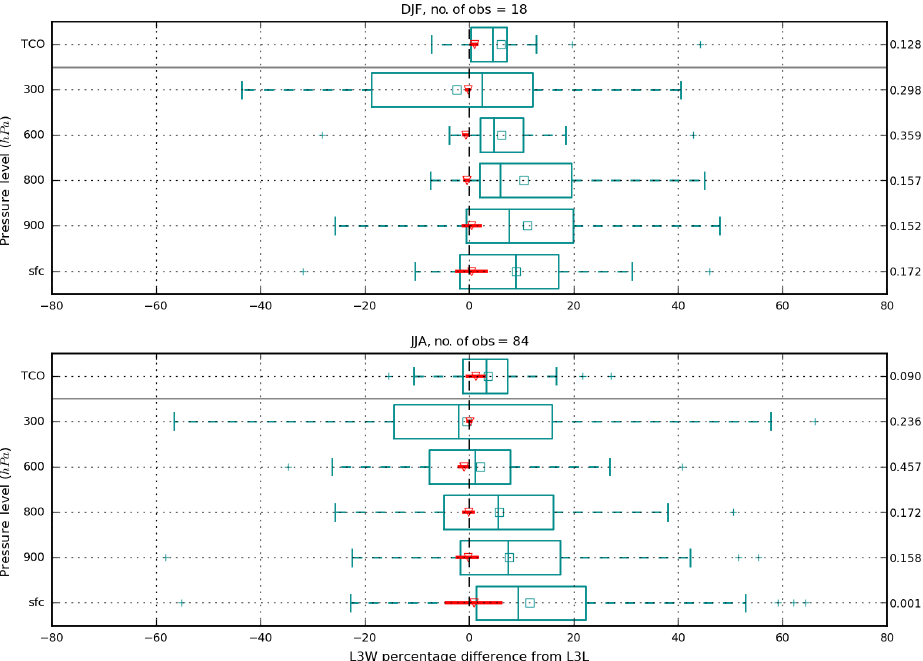
(cid:17) (cid:111) (cid:110)(cid:16) L3W · 100 − 100) between temporally L3L